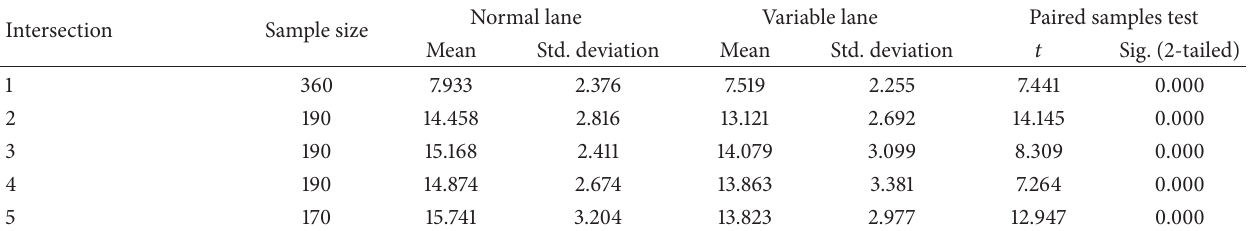
Table 5: Paired comparison of the traffic demand per cycle between the variable lane and the adjacent lane.